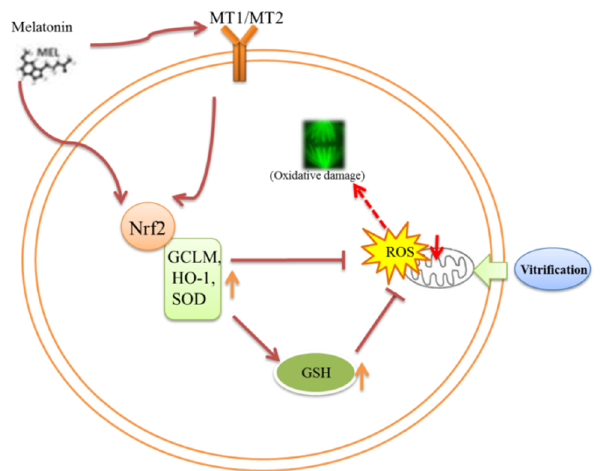
Figure 11. A schematic illustration of the cross talk between the Nrf2 signaling pathway activated by melatonin in vitrified-warmed mouse GV oocytes during in vitro maturation. MT1/MT2: mela- tonin receptors. Nrf2, GCLM, HO-1, SOD: antioxidant protein. GSH: glutathione. ROS: reactive oxygen